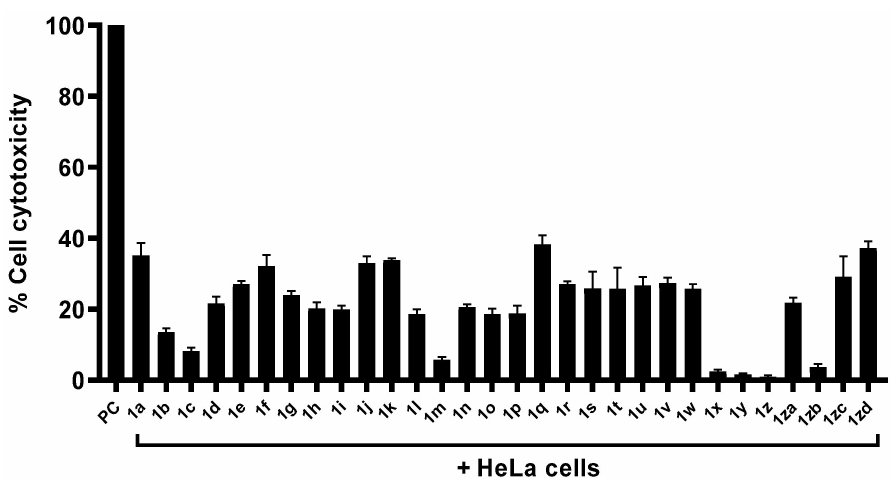
Figure 4. The impact of compounds and their analogues on human cells. Note that compounds and their analogues indicated marginal cytotoxic effects against human cell lines. Table 2. EC 50 and EC 90 of the most active compounds.